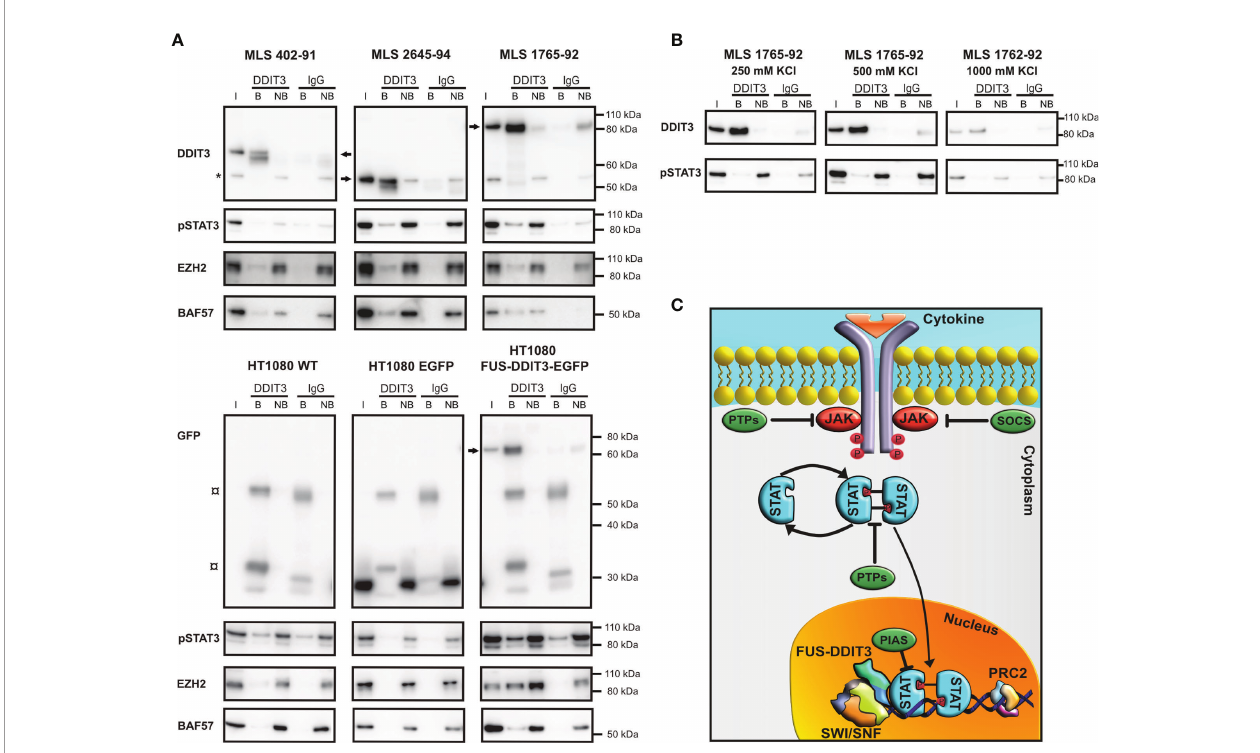
FIGURE 6 | FUS-DDIT3 interacting partners. (A) Western blot analysis of DDIT3 immunoprecipitation experiment in myxoid liposarcoma (MLS) (402-91, 2645-94, and 1765-92) and fi brosarcoma [HT1080 wild-type (WT), HT1080 EGFP, and HT1080 FUS-DDIT3-EGFP] cell lines, visualizing FUS-DDIT3 and coimmunoprecipitation of pSTAT3 (Tyr705), EZH2 (PRC2 component), and BAF57 (SWI/SNF component). Cells were treated with leukemia inhibitory factor for 30 min before harvest to maximize the level of pSTAT3. FUS-DDIT3 is detected by a DDIT3 antibody in MLS and a GFP antibody in fi brosarcoma cells. The molecular weights of FUS-DDIT3 variants are different between the cell lines, indicated by arrows. * indicates unspeci fi c background around 55 kDa in input and non-bound samples. ¤ indicates background from secondary antibody interaction with heavy (55 kDa) and light chain (25 and 35 kDa) of immunoprecipitation antibody. (B) Western blot analysis of DDIT3 immunoprecipitated in sequential salt extracts (250, 500, and 1,000 mM KCl) in MLS 1765-92 cells, visualizing FUS-DDIT3 and coimmunoprecipitation of pSTAT3. (C) Schematic picture of the JAK-STAT signaling pathway. Janus kinases are phosphorylated and activated by cytokine binding to receptors which result in phosphorylation and activation of STAT proteins that translocate into the nucleus, where they can regulate transcription of target genes. The SWI/SNF and PRC2 complexes are potentially involved in the pathway through interactions with FUS-DDIT3 and phosphorylated STAT3 (pSTAT3). Members of the PTP, SOCS, and PIAS families act as inhibitors of the pathway. Non-speci fi c IgG was used as a negative control. I, input sample from the nuclear extract (3% of input); B, bound fraction (proteins bound to target during immunoprecipitation); NB, non-bound fraction (proteins not bound to target during immunoprecipitation). All immunoprecipitation samples were evaluated on the same gel and bands for each antibody were treated equally even though separate rectangles are shown for improved visualization. Complete Western blot membranes are shown in Supplementary Figure 2